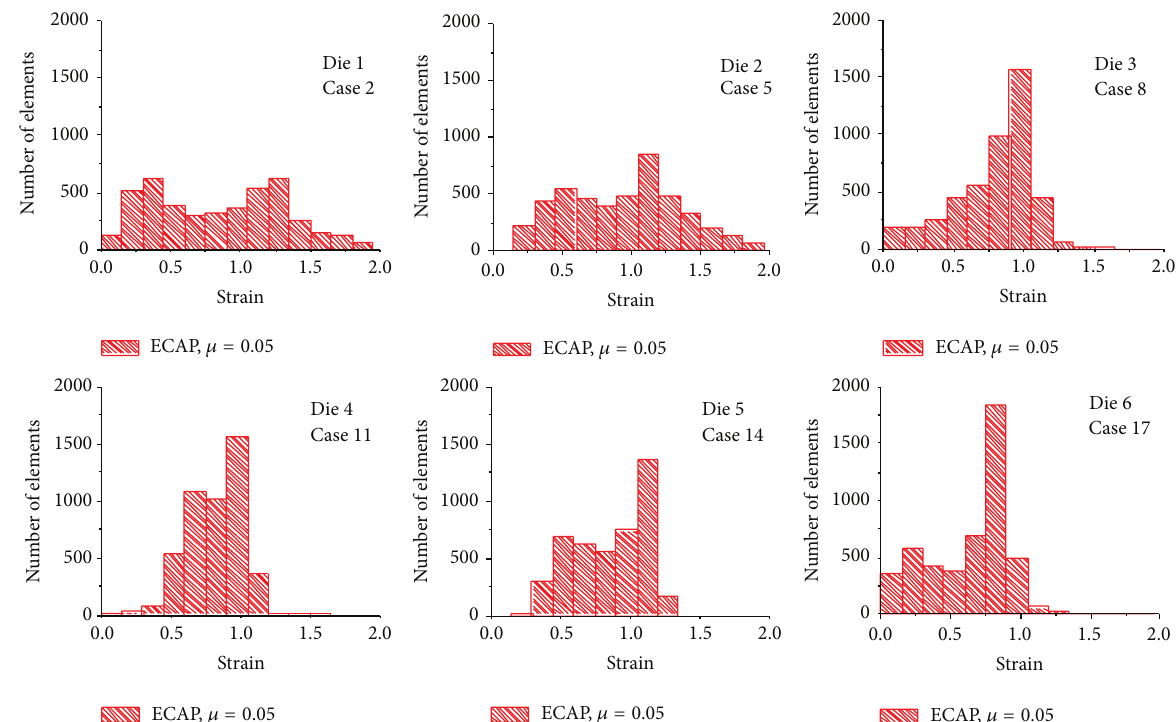
Figure 7: Deformation distribution curves level as a function of the friction coefficient during the ECAP processing, after one pass with the ECAP die’s six-channel